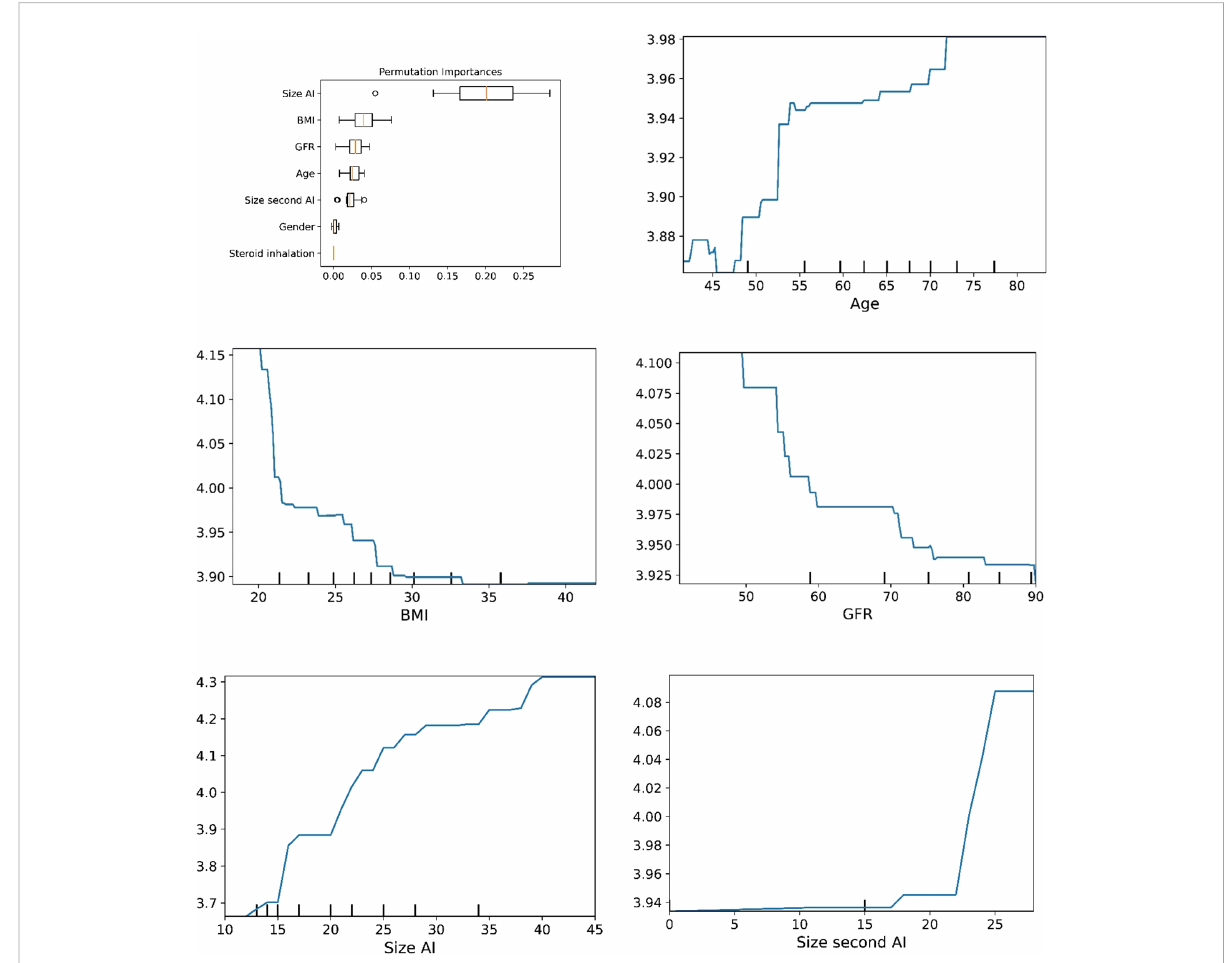
FIGURE 1 The plots for permutation importance and ln-transformed cortisol DST against age, BMI, eGFR, size of AI (in bilateral AI, the size of the largest AI), and size of the second AI using the ML model